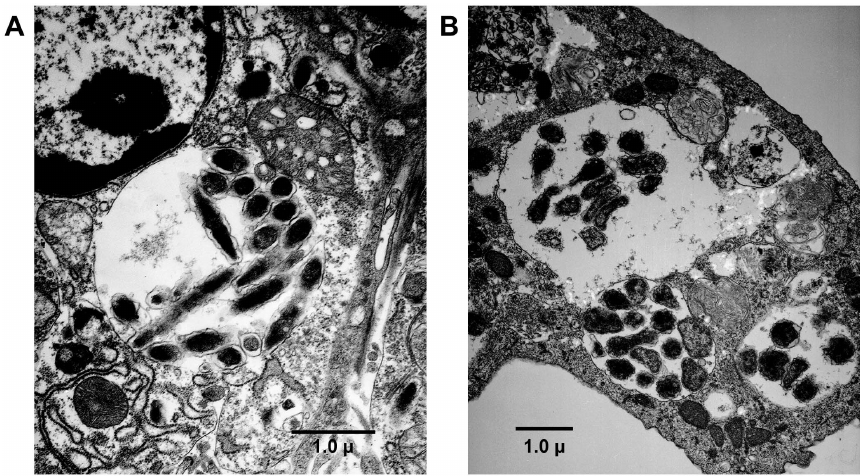
Figure 1. Transmission electron microscopy (TEM) analysis of E.chaffeensis infected ticks. E. chaffeensis organisms in a phagosome (morula) within the midgut cell of a PCR positive tick were observed under TEM (A). The organisms in the tick midgut tissue phagosome appear morphologically very similar to those observed in the in vitro cultured ISE6 tick cell phagosome (B) having a morula membrane, intra-morula space, inner and outer membranes and having inclusions of both dense core and elongated (dividing) cells.